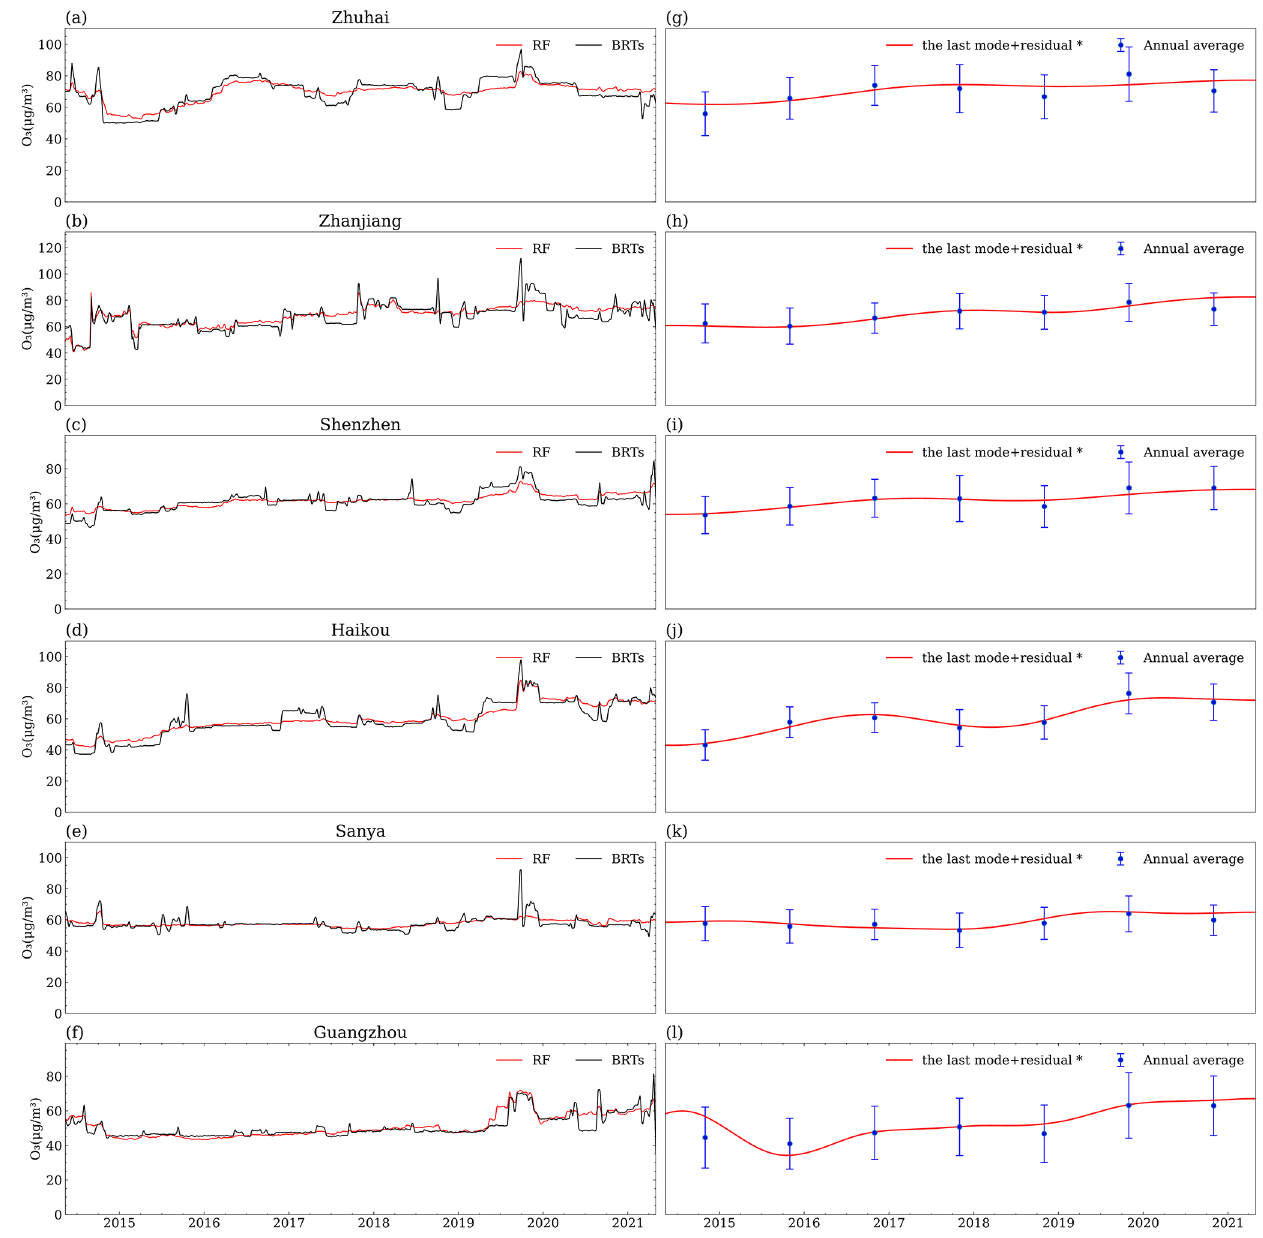
Figure 5. Same as Fig. 4 except for the pollutant being O 3